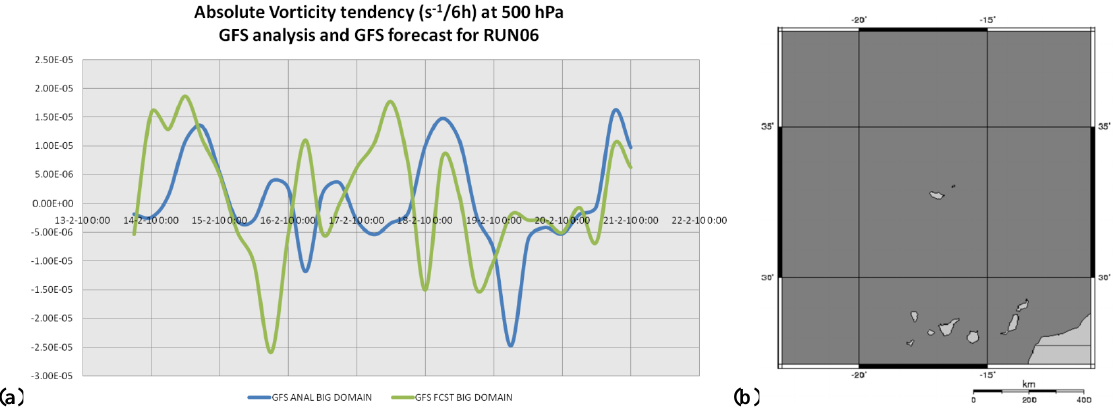
Fig. 4. (a) Area averaged absolute vorticity tendency, at the 500hPa isobaric surface, for the GFS analysis (blue) and forecast (green). The area considered is shown in (b).